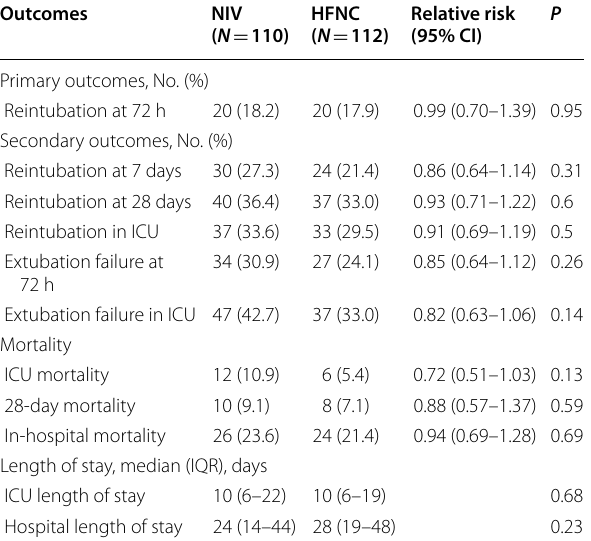
Fig. 2. The rate of reintubation at 7 days (24 [21.4] vs. 30